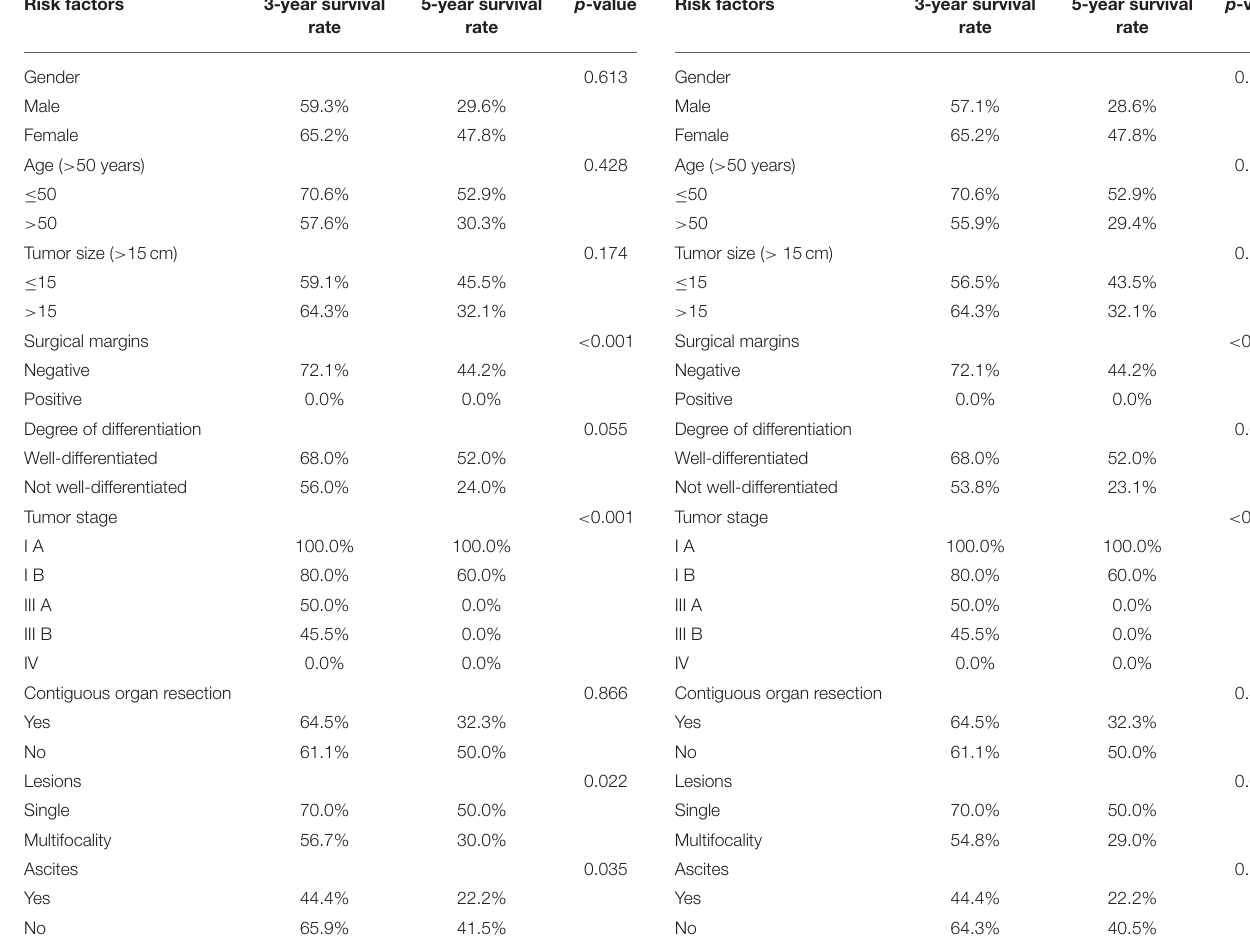
poor progression-free survival ( Table 4 ). Surgical margins [HR = 4.0674 P = 0.038] and tumor stage [HR = 1.167 P = 0.001] were also found to be independent predictors of poor overall survival ( Table 5